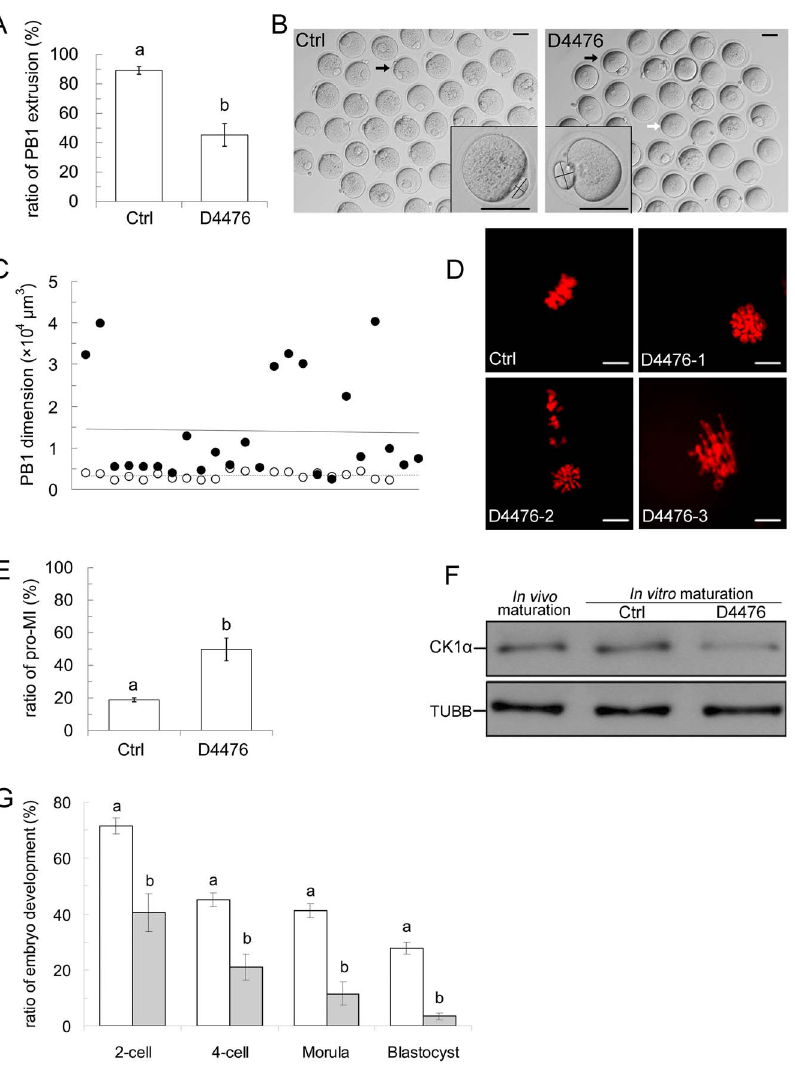
Figure 3. D4476, an inhibitor of CK1, caused oocyte maturation and embryo development failures. (A) D4476 caused a decrease in PB1 extrusion. t-Test was used to determine significance of difference for PB1 extrusion. Different superscripts on the bar indicate statistical difference (p , 0.01). (B) Representative images of oocytes incubated in D4476-containing medium and drug-free medium for 12 hours. Most of the oocytes in the control group reached the MII stage. Black arrow indicates representative oocyte with normal PB1 (left). Most of the oocytes incubated with D4476 can not extrude PB1. White arrow indicates representative oocyte without PB1 (right). Some oocytes extruded giant PB1. Black arrow indicates representative oocyte with giant PB1 (right). The representative oocytes are shown enlarged in the corner. Scale bar=50 m m. (C) PB1 dimension was measured in the control and D4476 treated groups. Hollow dots indicate the dimension of the control group and solid dots indicate the D4476 treatment group. Trendlines of PB1 dimension are shown in solid line (D4476) or dashed line (control). (D) Confocal microscopy image of the effect of D4476 on chromosome congression. Three abnormal types of chromosome conngression are shown: pro-MI stage (D4476-1), dispersive chromosomes (D4476-2), and disorganized chromosome (D4476-3). Red: DNA, Scale bar=5 m m. (E) D4476 induced a high ratio of pro-MI arrest. t-Test was used to determine significance of difference for the ratio of pro-MI arrest. Different superscripts on the bar indicate statistical difference (p , 0.01). (F) Western blot of CK1 a in in vivo maturation, in vitro maturation and D4476-treated oocytes. 200 oocytes for each sample were lysed in Laemmli buffer. TUBB was used as a loading control. The molecular mass of CK1 a and b -tubulin were about 39 kDa and 53 kDa, respectively. The results of one representative of three independent experiments are presented. (G) D4476 affected early embryo development. Oocytes were incubated in D4476-containing or D4476-free CZB medium for 12 hours. Oocytes with PB1 were inseminated and embryo developmental rates were recorded. t- Test was used to determine significance of difference between control and D4476 groups. Within the same stage, percentages without a common letter are different (P , 0.01).